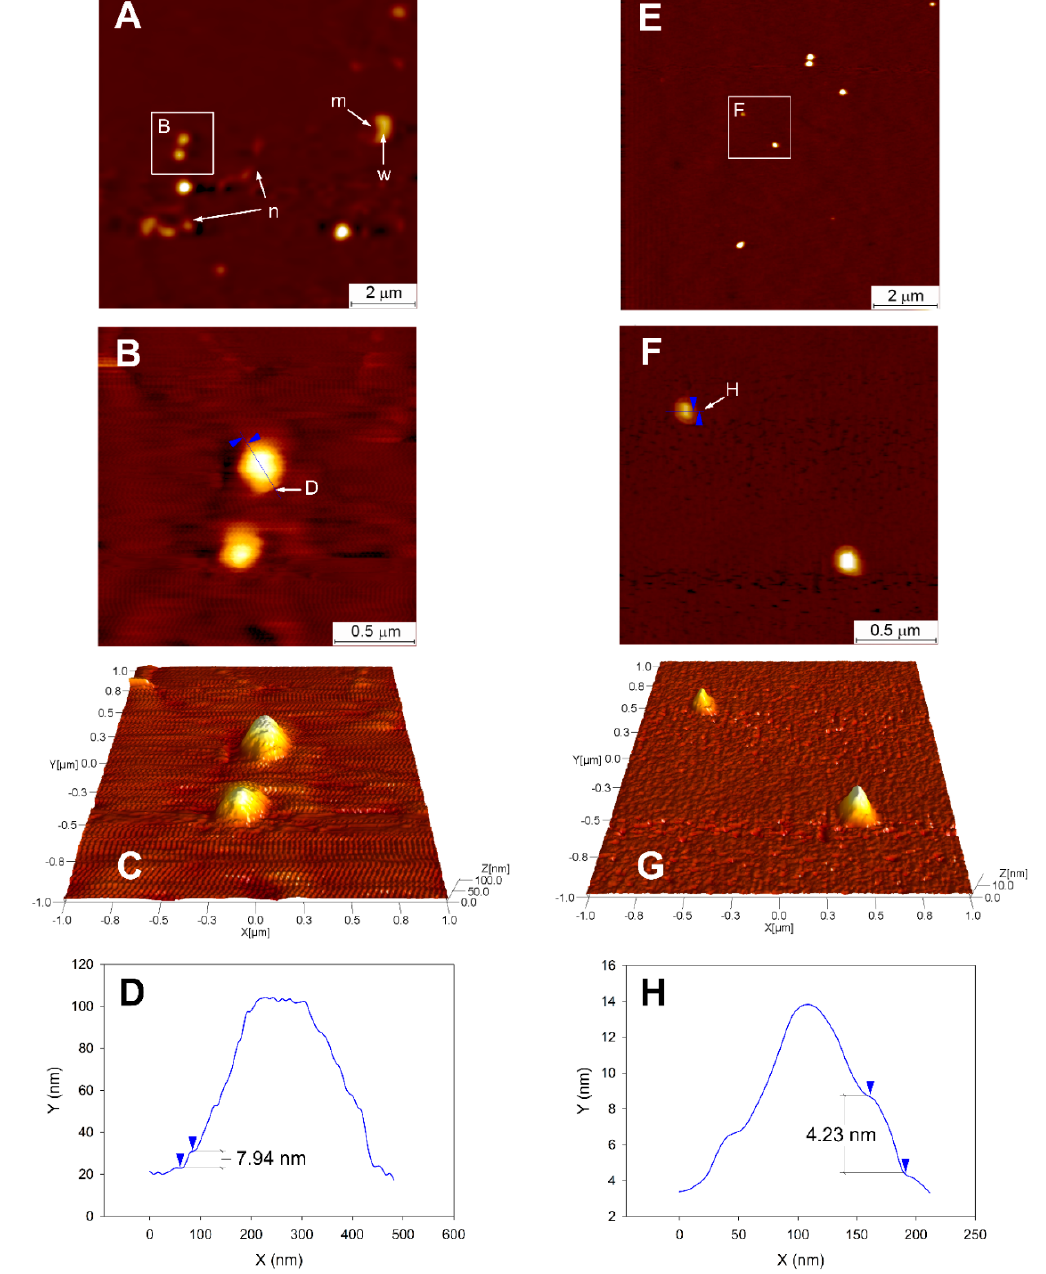
Figure 2. Atomic force microscopy image of ( A ) CEP-1:3 and ( B ) CSP-1:3. CSP-1:3 and CEP-1:3 adsorbed on a microscopic slide were analyzed using AFM in a non-contact mode. ( B ) and ( F ) are magnified AFM images of the area indicated by the solid white squares in ( A ) and ( E ), respectively. ( C ) and ( G ) are three dimensional images of (B) and (F) , respectively. ( D ) and ( H ) are cross-sections following the line in ( B ) and ( F ), respectively. Cursors indicated in ( B ) and ( F ) geometrically correspond to those in ( D ) and ( H ), respectively. “m” and “n” indicate a ruptured CSP-1:3 and debris of torn CSP-1:3. “w” indicates a part of ruptured CSP-1:3 (m) bearing remnant water.